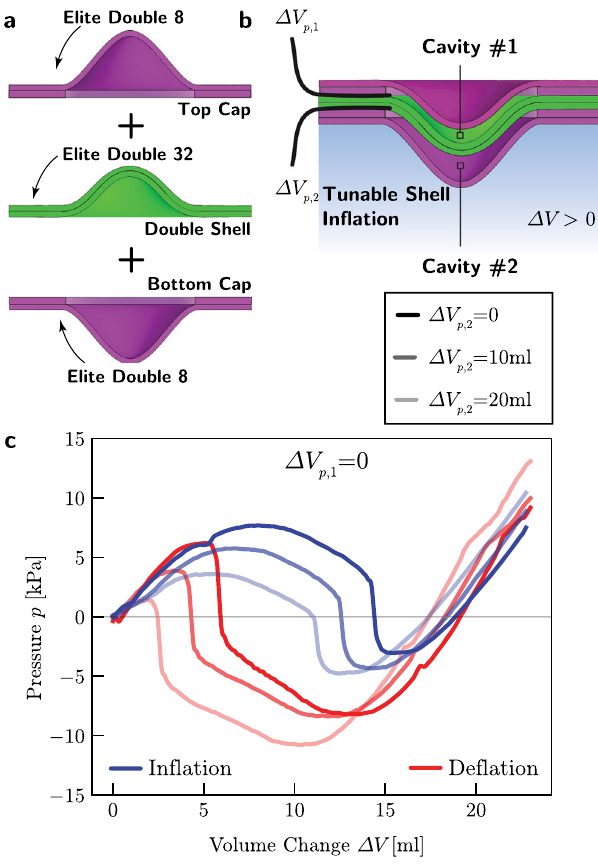
Fig. 6 Shells with tunable energy landscape. a Our tunable shell comprises a double shell and two single shell caps. b Geometry of the tunable shell. c Experimental pressure-volume relationship for the tunable shell during its quasi-static in fl ation (blue) and de fl ation (red) for 3 different levels of pre- in fl ation for an internal cavity.